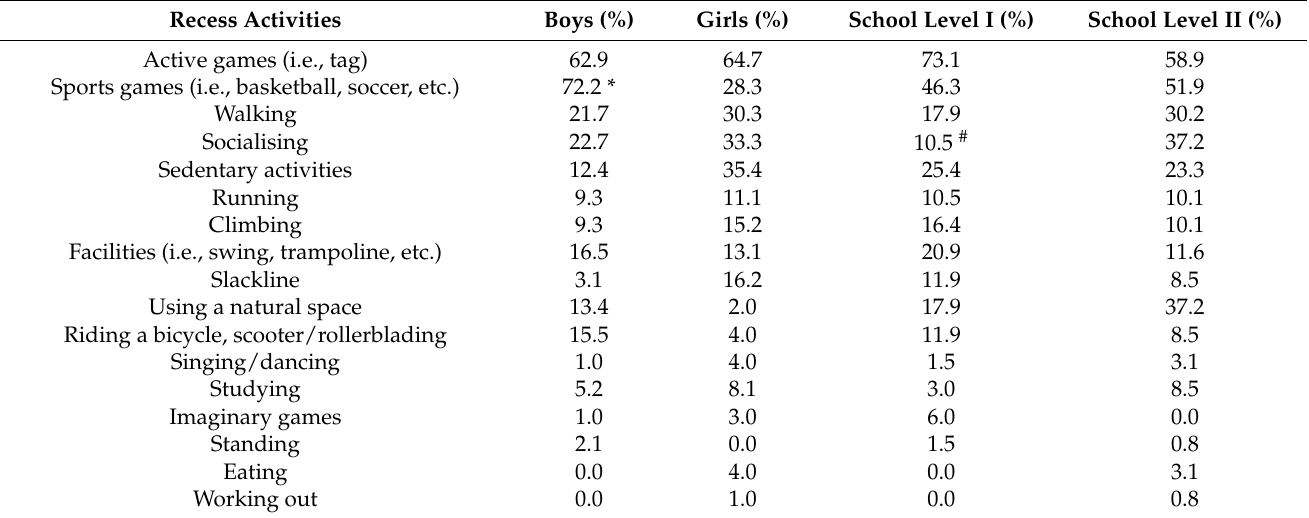
Table 2. Outdoor recess activity preference shown in percentage (%), comparison between genders and school